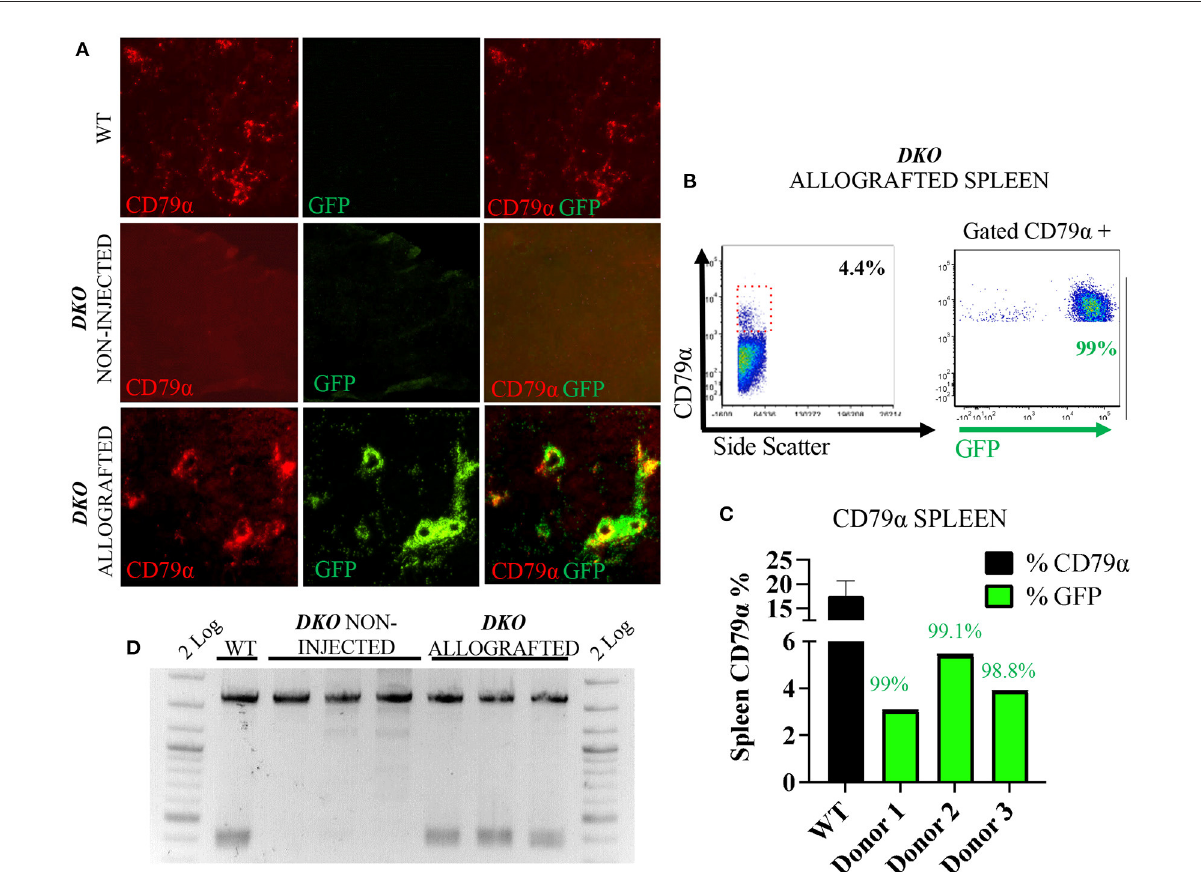
FIGURE4 In utero allogeneic transplantation of pH2B-eGFP fetal liver cells restored B cells and IgH recombination in the spleen of 1-week-old DKO pigs. (A) Immunofluorescence staining (20x magnification) for CD79 α (red), and pH2B-eGFP (GFP-green). Overlay images are also represented. Wild-type spleen contains CD79 α + cells, but not pH2B-eGFP positive cells. Spleen of non-injected DKO pigs is negative for both CD79 α + and pH2B-eGFP cells. The spleen of allografted DKO pigs contains CD79 α + cells, all overlapping with pH2B-eGFP cells. (B) Representative flow cytometry plot from DKO allografted spleen showing expression of CD79 α . A red box indicates the CD79 α positive cells within the spleen. Representative flow cytometry of gated CD79 α + cells expressing pH2B-eGFP is also shown. (C) Histogram showing the percentage of CD79 α + cells from the spleen of all three DKO allografted pigs, while wild type ( n = 3) serves as a positive control. Green histogram represents the levels of pH2B-eGFP chimerism, indicating the percentage of allograft donor-origin cells in the CD79 α + population. (D) PCR assay for the identification of rearranged IgH locus from spleen gDNA. Non-injected DKO spleen serve as negative controls, and a wild type as a positive control. All three allografted piglets display IgH rearranged